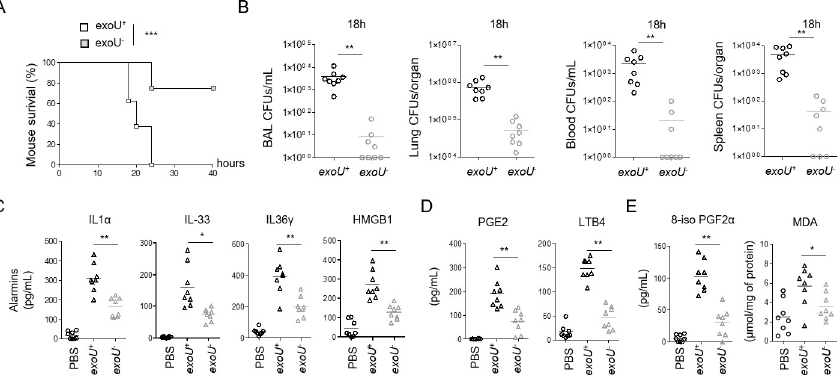
Fig 1. ExoU-dependent lung pathology in mice associates to an alarmin and peroxidized lipid signature. (A) Survival of WT mice intranasally infected (n = 7 animals per condition) with 5.10 5 CFUs of P . aeruginosa PP34 or its isogenic mutant PP34 exoU- . Graphs represent one experiment (8 mice/group) out of three independent in vivo experiments. Log-rank Cox-Mantel test was used for survival comparisons. ��� p � 0.001. (B) Bronchoalveolar (BAL), lung, blood and spleen bacterial loads from WT mice (n = 8) 18 hours after intranasal infection with 5.10 5 CFUs of P . aeruginosa PP34 or its isogenic mutant PP34 exoU- . Graphs represent one experiment (8 mice/group) out of three independent in vivo experiments. �� p � 0.01, Mann-Whitney analysis test. (C) Alarmin levels in bronchoalveolar fluids (BALFs) from WT mice (n = 8) 6 hours after intranasal infection with 5.10 5 CFUs of P . aeruginosa PP34 or its isogenic mutant PP34 exoU- . Graphs represent one experiment (8 mice/group) out of three independent in vivo experiments; � p � 0.05; �� p � 0.01, Mann-Whitney analysis test. (D) Prostaglandin E2 (PGE2) and Leukotriene B4 (LTB4) levels in bronchoalveolar fluids (BALFs) from WT mice (n = 8) 6 hours after intranasal infection with 5.10 5 CFUs of P . aeruginosa PP34 or its isogenic mutant PP34 exoU- . Graphs represent one experiment (8 mice/group) out of three independent in vivo experiments; �� p � 0.01, Mann-Whitney analysis test. (E) Peroxidized lipid product (isoprostanes and MDA) levels in bronchoalveolar fluids (BALFs) from WT mice (n = 8) 6 hours after intranasal infection with 5.10 5 CFUs of P . aeruginosa PP34 or its isogenic mutant PP34 exoU- . Graphs represent one experiment (8 mice/group) out of three independent in vivo experiments; � p � 0.05; �� p � 0.01, Mann-Whitney analysis test. Data information: Data shown as means ( Graphs B-E ) and are representative of one experiment performed three times; � p � 0.05; �� p � 0.01, ��� p � 0.001, Mann-Whitney analysis test ( B-E) and log-rank Cox-Mantel test for survival comparisons ( A